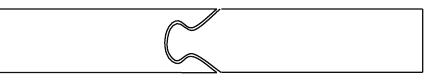
Figure 2: “ Ω ” shaped blades.